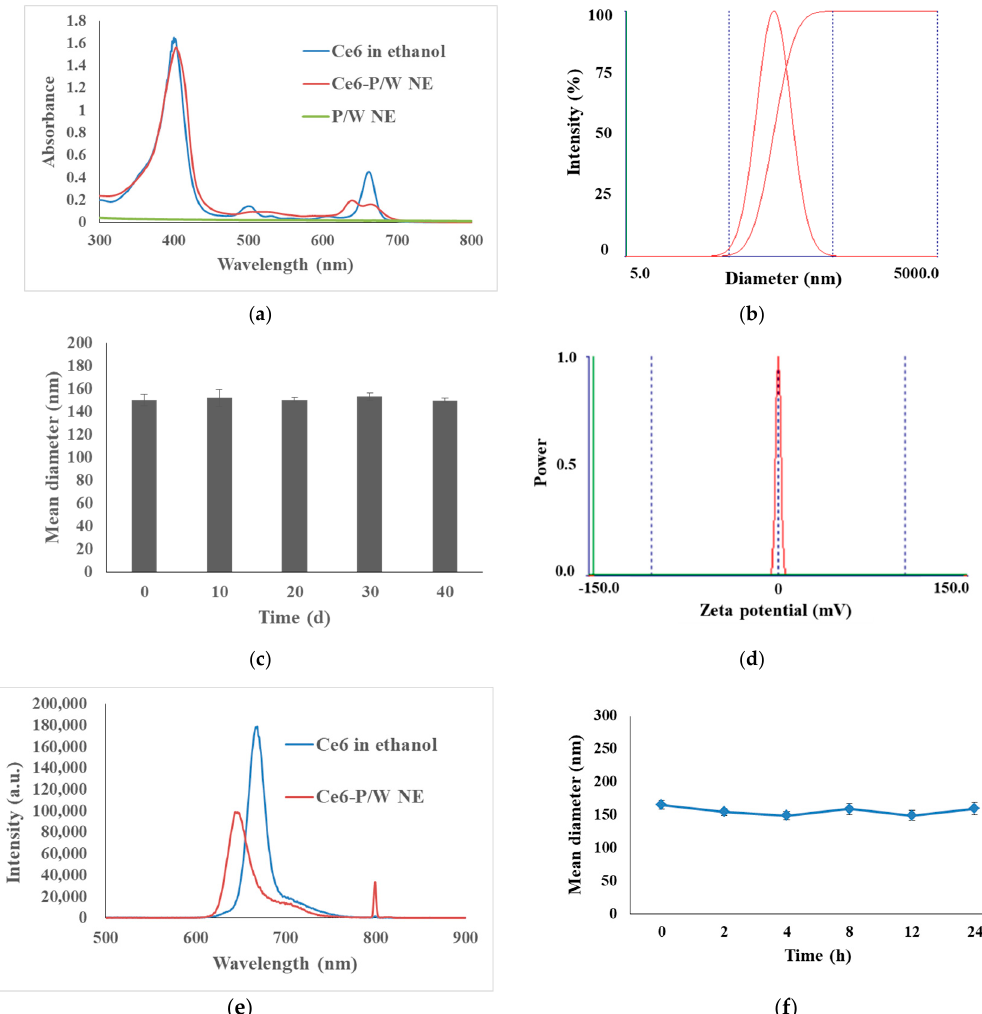
Figure 1. Characterization of physicochemical properties of Ce6-P/W NE nanodroplets. ( a ) Characterization of physicochemical properties of Ce6-P / W NE nanodroplets. Ultraviolet–visible light absorption spectrum. Ce6 concentration, 12 μ g/mL. ( b ) Hydrodynamic ( a ) Ultraviolet–visible light absorption spectrum. Ce6 concentration, 12 µ g / mL. ( b ) Hydrodynamic diameter. Ce6 concentration, 16 μ g/mL. ( c ) Physical stability: Plot shows droplets size for different diameter. Ce6 concentration, 16 µ g / mL. ( c ) Physical stability: Plot shows droplets size for di ff erent storage periods at 4 °C. Ce6 concentration, 16 μ g/mL. ( d ) Zeta potential. Ce6 concentration, 16 μ g/mL. storage periods at 4 ◦ C. Ce6 concentration, 16 µ g / mL. ( d ) Zeta potential. Ce6 concentration, 16 µ g / mL. ( e ) Fluorescence emission spectra of Ce6 dissolved in ethanol and Ce6-P/W NE with the same Ce6 ( e ) Fluorescence emission spectra of Ce6 dissolved in ethanol and Ce6-P / W NE with the same Ce6 concentration (12 μ g/mL). ( f ) Droplet diameter change of the Ce6-P/W NEs in DMEM cell culture concentration(12 µ g / mL).( f )DropletdiameterchangeoftheCe6-P / WNEsinDMEMcellculturemedium medium supplemented with 10% fetal bovine serum throughout storage at 37 °C for 24 h. Ce6 supplemented with 10% fetal bovine serum throughout storage at 37 ◦ C for 24 h. Ce6 concentration, concentration, 16 μ g/mL. All data were presented as mean value ± standard deviation. After Levene’s 16 µ g / mL. All data were presented as mean value ± standard deviation. After Levene’s test for equality test for equality of variances, one-way analysis of variance (ANOVA) and Bonferroni multiple of variances, one-way analysis of variance (ANOVA) and Bonferroni multiple comparison test was comparison test was employed for the comparison of mean values. n = 3. Ce6-P/W NE, chlorin e6- employed for the comparison of mean values. n = 3. Ce6-P / W NE, chlorin e6-perfluoropolyether perfluoropolyether (PFPE)/water nanoemulsion. (PFPE) / water